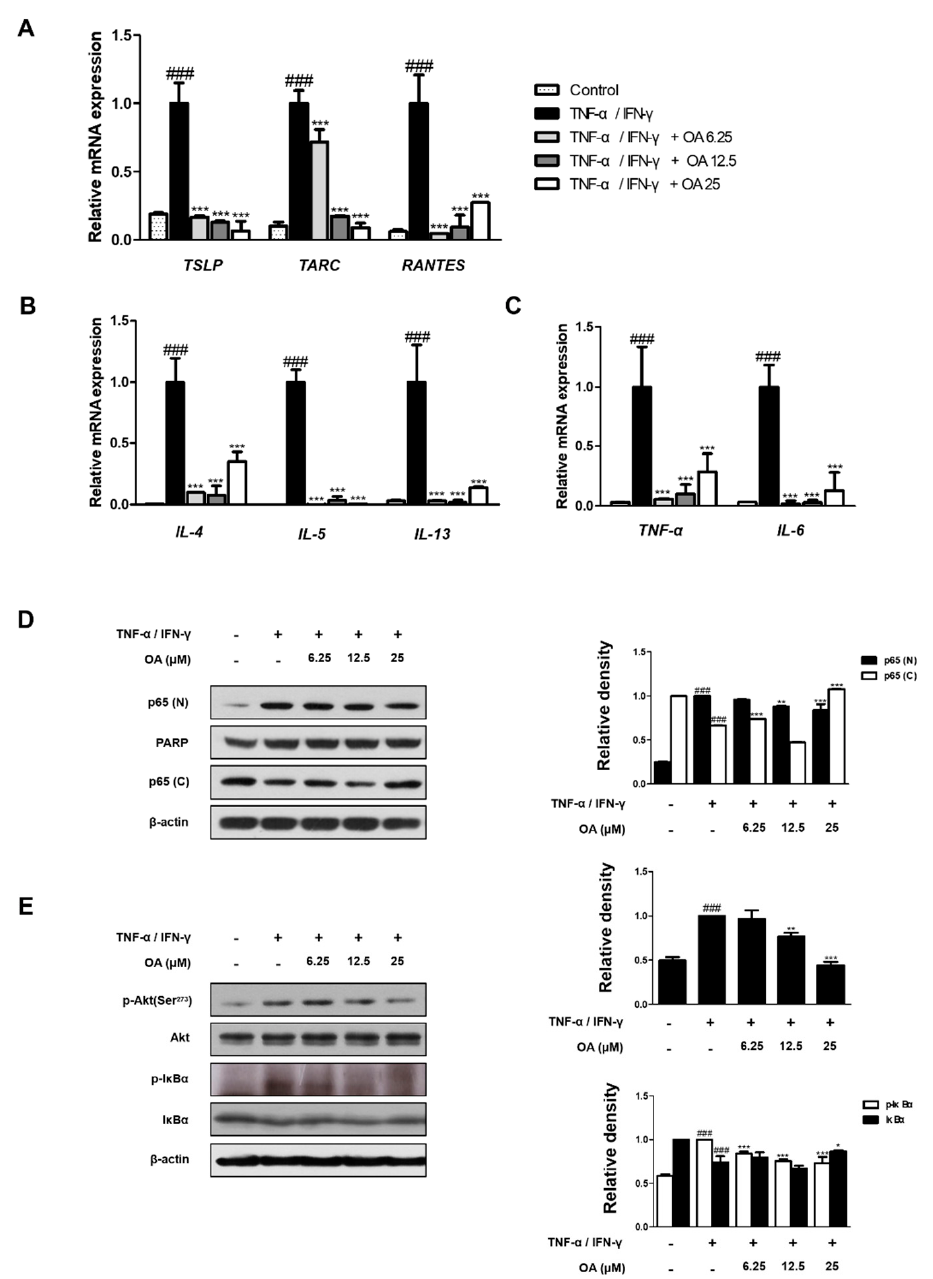
Figure 5. Effect of OA on chemokine and NF- κ B and Akt activation in TNF- α /IFN γ -stimulated HaCaT cells ( A – C ) The mRNA level of cytokines and chemokines in HaCaT cells were determined by qRT-PCR. ( D , E ) Total proteins were prepared, and Western blot analysis was performed using specific antibodies. β -actin was used as internal control. Densitometric analysis was performed using Bio-Rad Quantity One ® Software. The data shown represent mean ± S.D. of three independent experiments. ### p < 0.001 vs. the control group; * p < 0.05, ** p < 0.01, and *** p < 0.001 vs. TNF- α /IFN- γ -treated group.